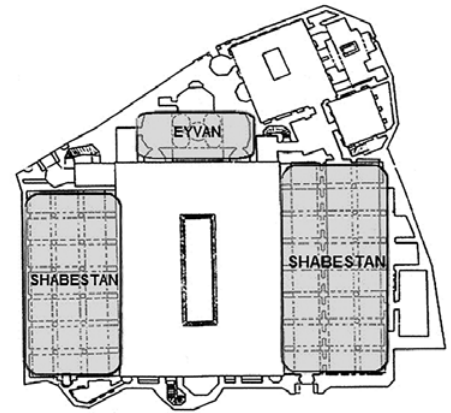
fig. 9. Placement of Shabestan and Eyvan in nasiralmolk Mosque (Behpoor map 1383)